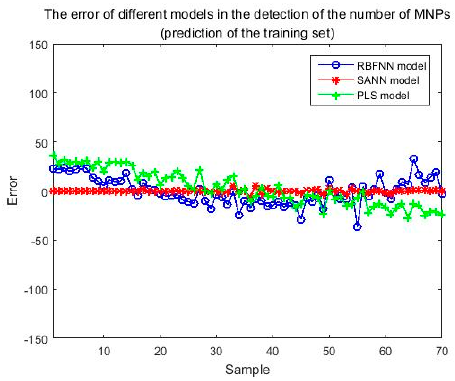
Figure 19. Comparison of the prediction errors of different MNPs number detection models (the training set).